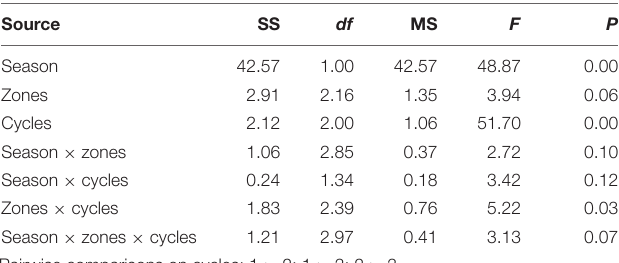
TABLE 2 | Three-way repeated measures ANOVA comparing plastic pellet inputs across different local-scale phenomena; including sampling season (onset vs.